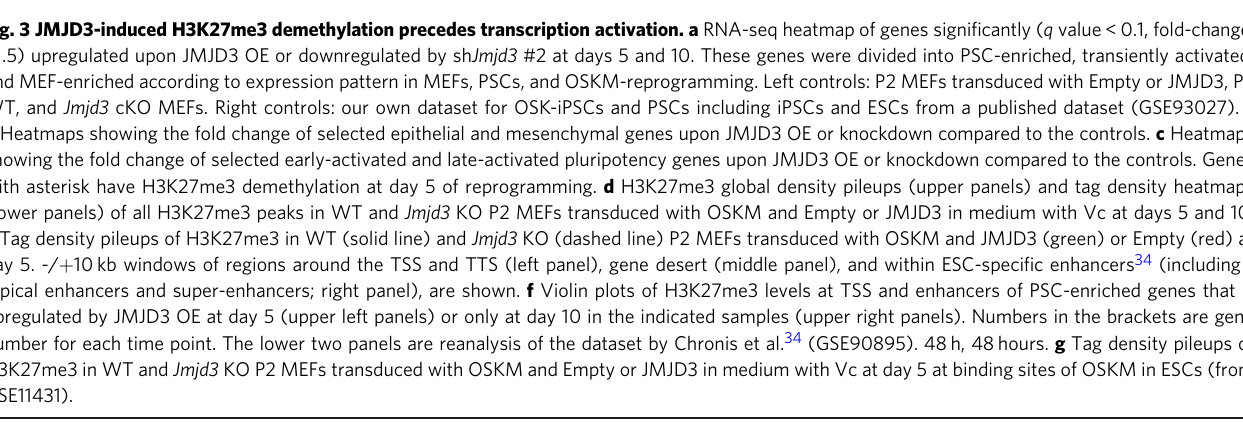
Fig. 3 JMJD3-induced H3K27me3 demethylation precedes transcription activation. a RNA-seq heatmap of genes signi fi cantly ( q value < 0.1, fold-change >1.5) upregulated upon JMJD3 OE or downregulated by sh Jmjd3 #2 at days 5 and 10. These genes were divided into PSC-enriched, transiently activated, and MEF-enriched according to expression pattern in MEFs, PSCs, and OSKM-reprogramming. Left controls: P2 MEFs transduced with Empty or JMJD3, P2 WT, and Jmjd3 cKO MEFs. Right controls: our own dataset for OSK-iPSCs and PSCs including iPSCs and ESCs from a published dataset (GSE93027). b Heatmaps showing the fold change of selected epithelial and mesenchymal genes upon JMJD3 OE or knockdown compared to the controls. c Heatmaps showing the fold change of selected early-activated and late-activated pluripotency genes upon JMJD3 OE or knockdown compared to the controls. Genes with asterisk have H3K27me3 demethylation at day 5 of reprogramming. d H3K27me3 global density pileups (upper panels) and tag density heatmaps (lower panels) of all H3K27me3 peaks in WT and Jmjd3 KO P2 MEFs transduced with OSKM and Empty or JMJD3 in medium with Vc at days 5 and 10. e Tag density pileups of H3K27me3 in WT (solid line) and Jmjd3 KO (dashed line) P2 MEFs transduced with OSKM and JMJD3 (green) or Empty (red) at day 5. -/ + 10 kb windows of regions around the TSS and TTS (left panel), gene desert (middle panel), and within ESC-speci fi c enhancers 34 (including typical enhancers and super-enhancers; right panel), are shown. f Violin plots of H3K27me3 levels at TSS and enhancers of PSC-enriched genes that upregulated by JMJD3 OE at day 5 (upper left panels) or only at day 10 in the indicated samples (upper right panels). Numbers in the brackets are gene number for each time point. The lower two panels are reanalysis of the dataset by Chronis et al. 34 (GSE90895). 48 h, 48 hours. g Tag density pileups of H3K27me3 in WT and Jmjd3 KO P2 MEFs transduced with OSKM and Empty or JMJD3 in medium with Vc at day 5 at binding sites of OSKM in ESCs